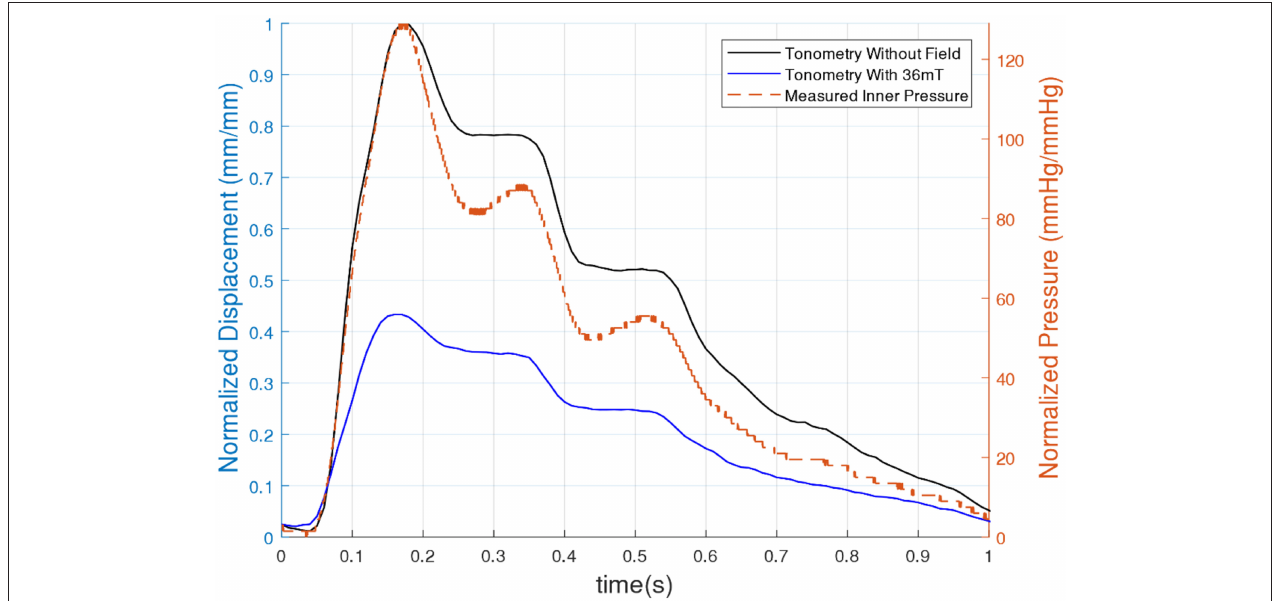
FIGURE 8 | Pressure and normalized displacement vs. time for a 75g load with and without an applied magnetic